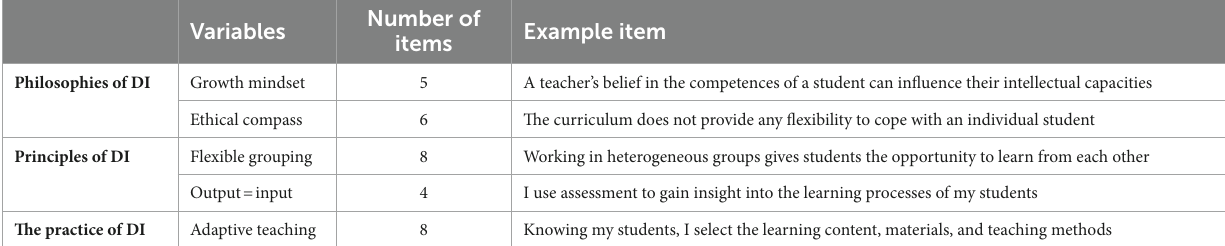
TABLE 1 The description of DI-Quest